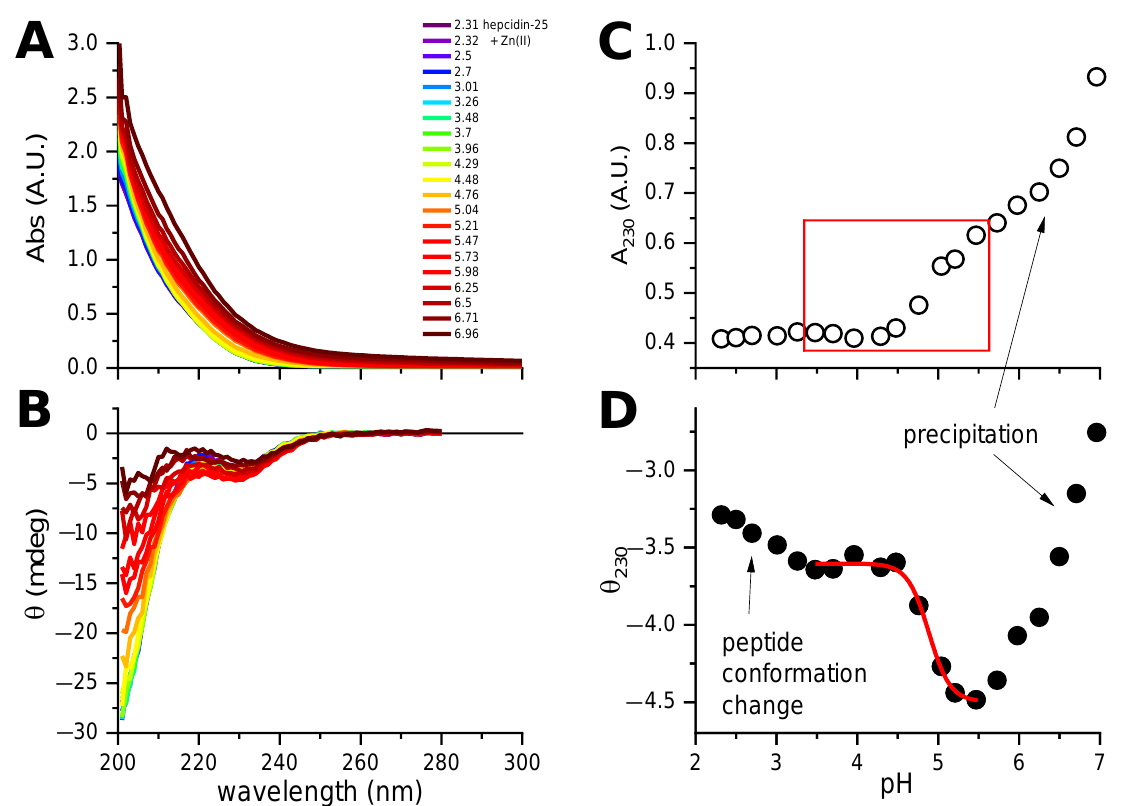
Figure 3. The pH- metric titration of 15.5 μM hepcidin -25 with 2 eq. of ZnCl 2 in the presence of 0.5 mM TCEP. ( A ). UV-vis spectra; ( B ). CD spectra, with the common color codes for pH in plot A; ( C ). The pH dependence of A 230 in the UV-vis spectra, showing the Zn(II) binding range (red box) and the loss of solution transparency due to peptide precipitation; ( D ). Fitting of the one-site binding model to the CD data at 230 nm. Arrows point to pH regions pertaining to comments in plots.